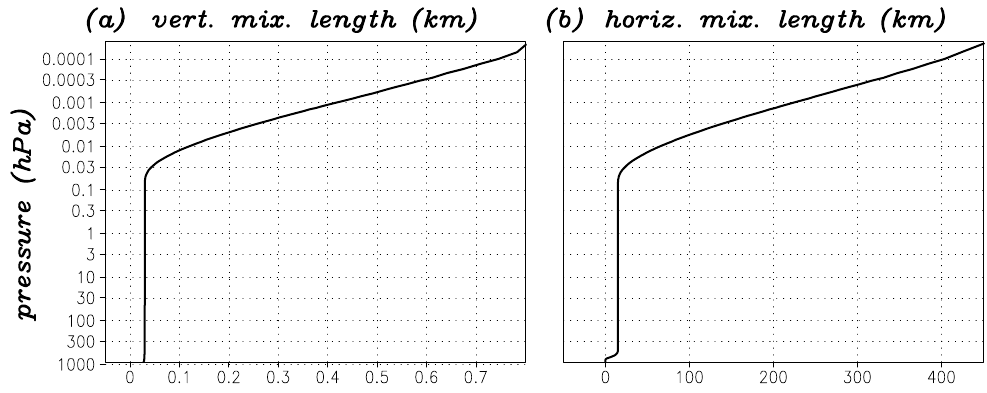
Fig. 3. Assumed vertical profiles of (a) the asymptotic vertical mixing length and (b) the horizontal mixing length.